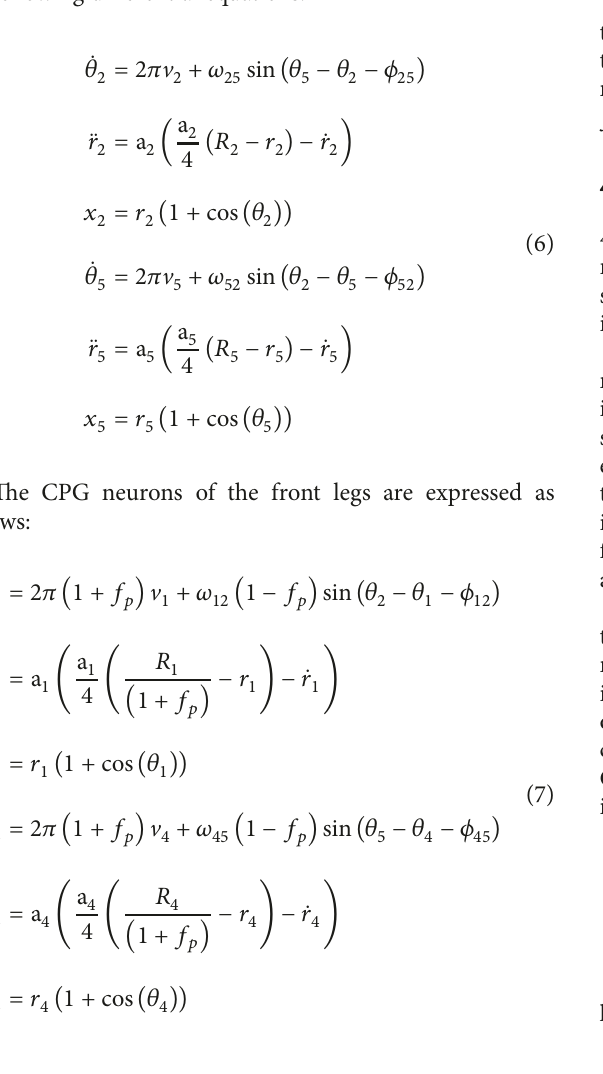
Adapting from this model, our CPG model is shown as